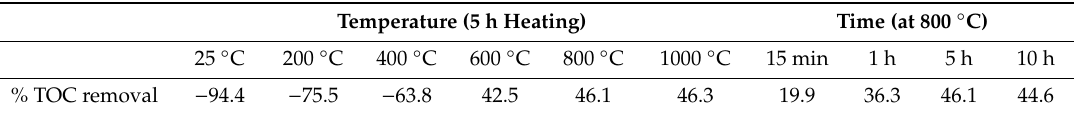
Table 1. E ff ect of carbonization temperature and duration on the electro-Fenton performance of carbon felt electrodes modified with carbonized MIL-53(Fe).